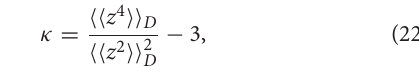
D and the diffusivity difference D 0 over a range of the strength of heterogeneity δ (with fixed D 0 − ∞ ∞ ρδ 2 / (24 π 3 / 2 σ 3 D 0 D 0 σ − ∞ =